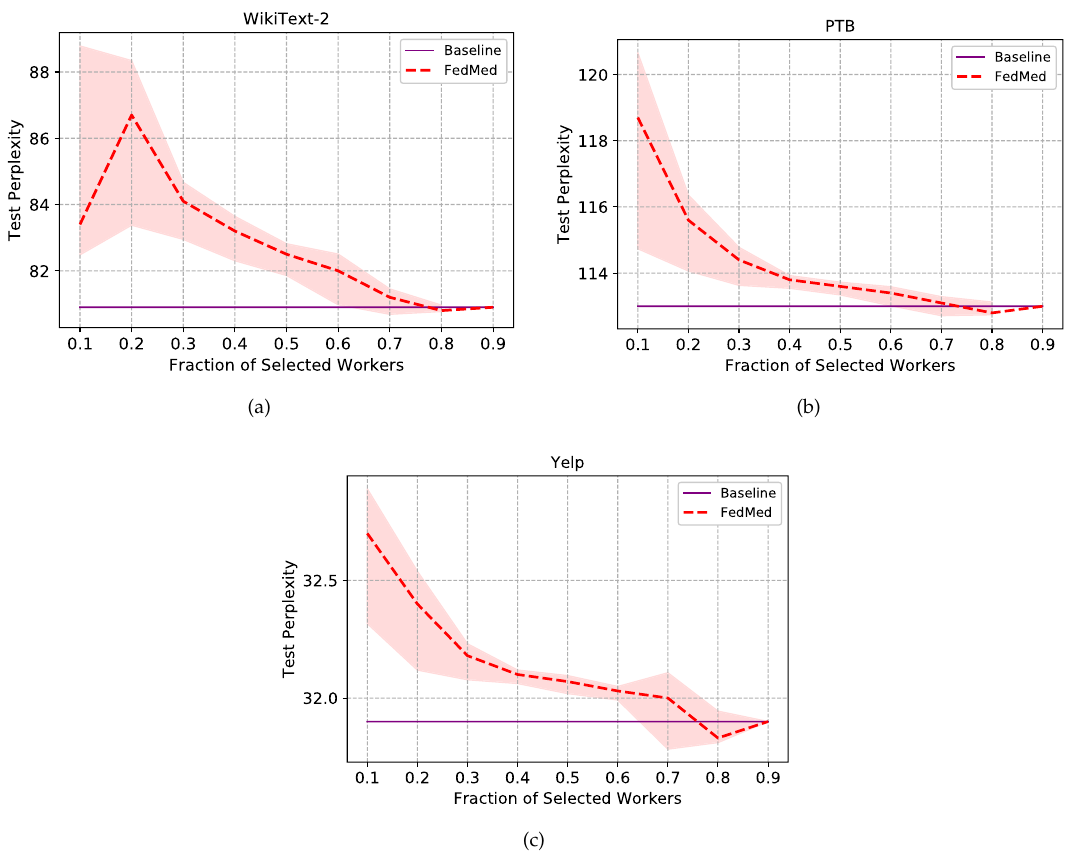
Figure 5. Experimental results of communication efficiency with topK strategy on test sets. The purple line stands for the baseline without topK strategy in three datasets. ( a )Test perplexity on test set of WikiText-2. ( b )Test perplexity on test set of Penn Treebank. ( c )Test perplexity on test set of